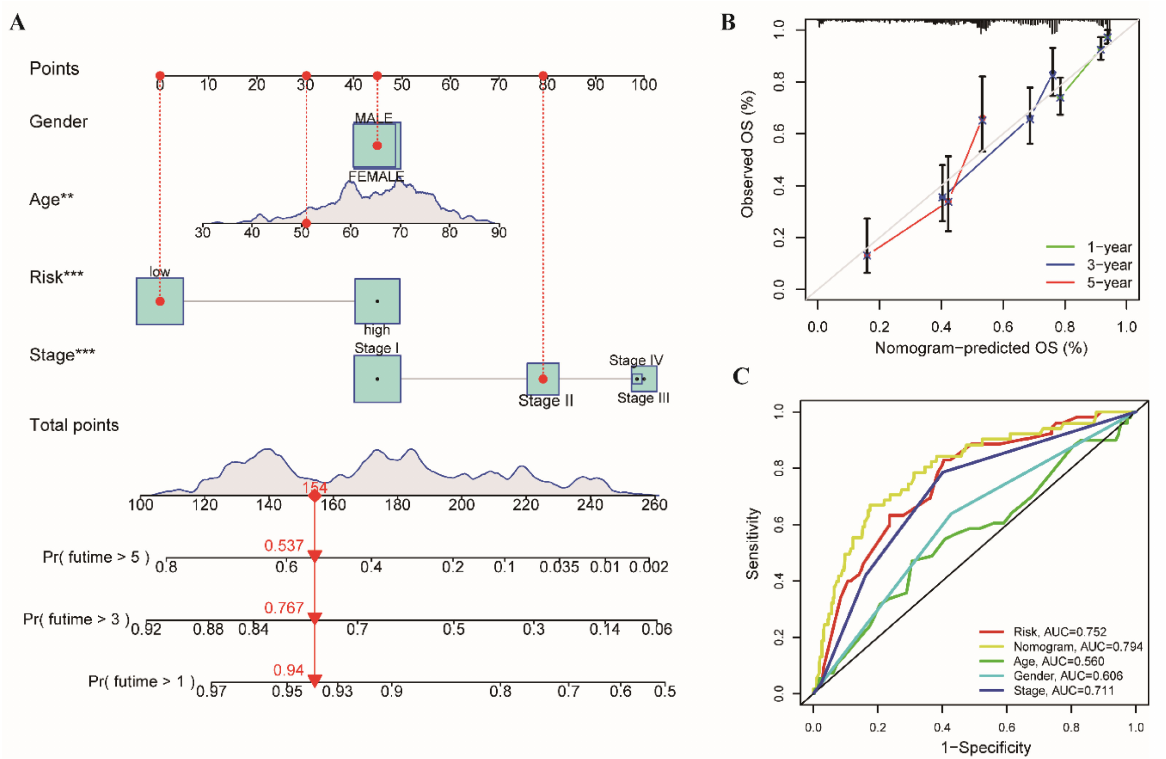
Figure 7. Establishment and evaluation of the nomogram of patients with LUAD in the TCGA cohort. ( A ) The survival prediction of patients with risk groups and clinical features was shown in the nomogram. ( B ) The calibration curves of the nomogram for the predicted OS probability and observed OS at 1-year, 3-year, and 5-year. ( C ) ROC curves of the nomogram. (** p < 0.01; *** p <